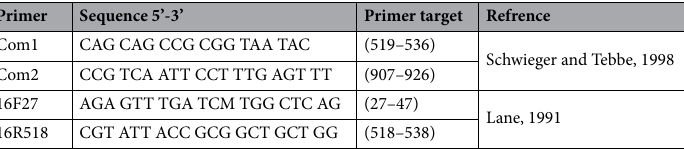
Table 2. Characterization of primers used for SSCP-based microbial-community